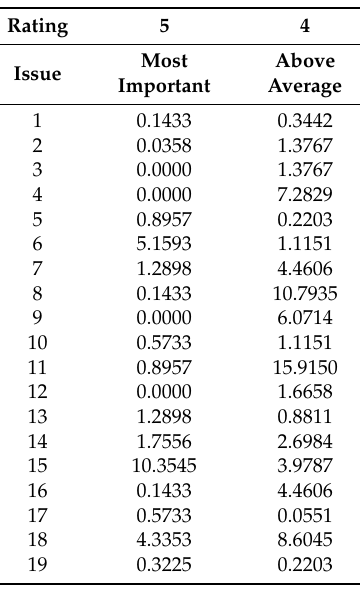
Table 19. Data in Normalised